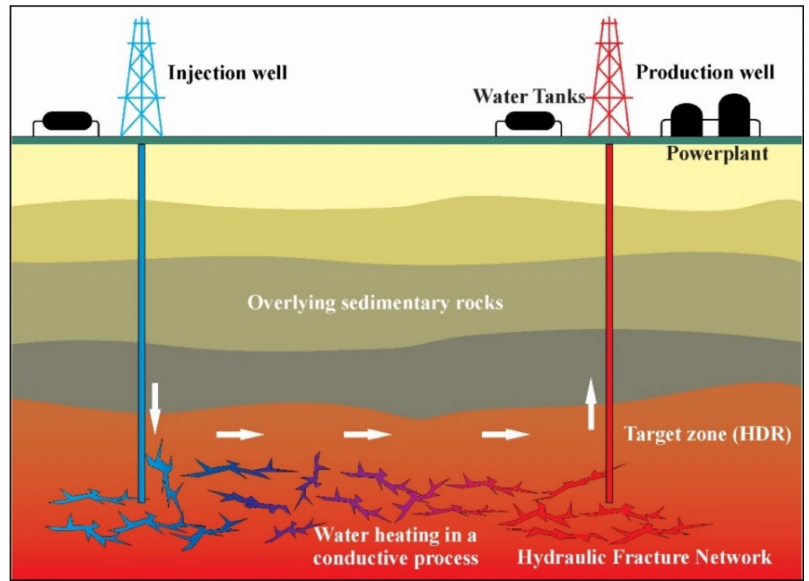
Figure 1. Schematic diagram of the operation of an enhanced geothermal system (modified after Moska et al. [18] and Zhou et al.